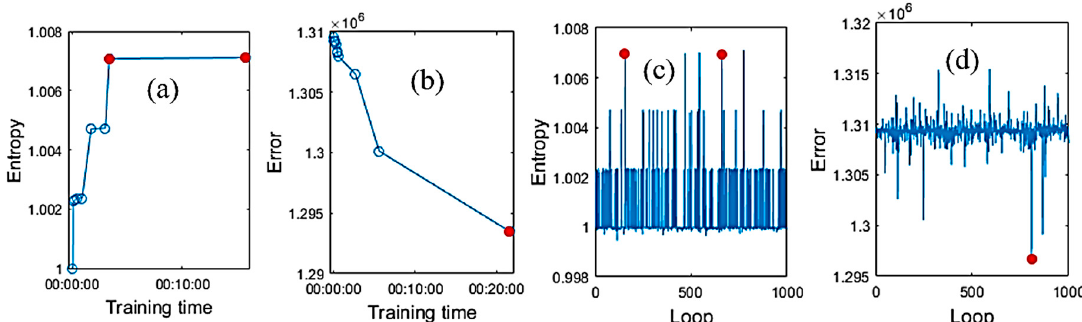
Figure 10. The entropies and AMEs were achieved from the training NN, which was trained in 1000 loops for λ 1 thermopile. The red dots show the optimization values. ( a ) Entropies from applying entropy for the differentiated MP data; ( b ) errors from applying the AME criterion; ( c ) recorded entropies after 1000 loops and ( d ) recorded errors after 1000 loops.